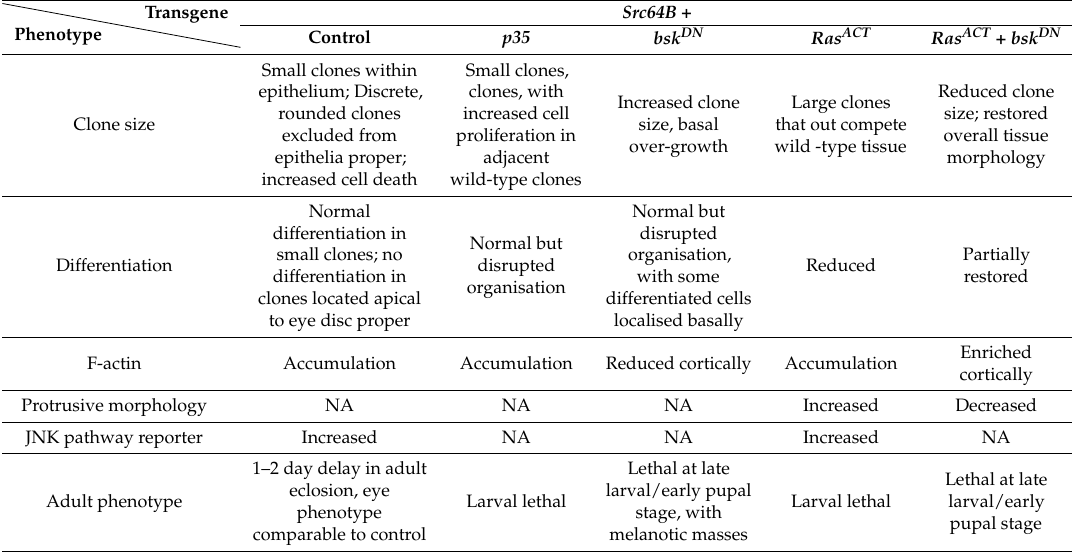
Table 3. Summary of phenotypes of ey-FLP MARCM third instar eye clones expressing Src64B with the indicated